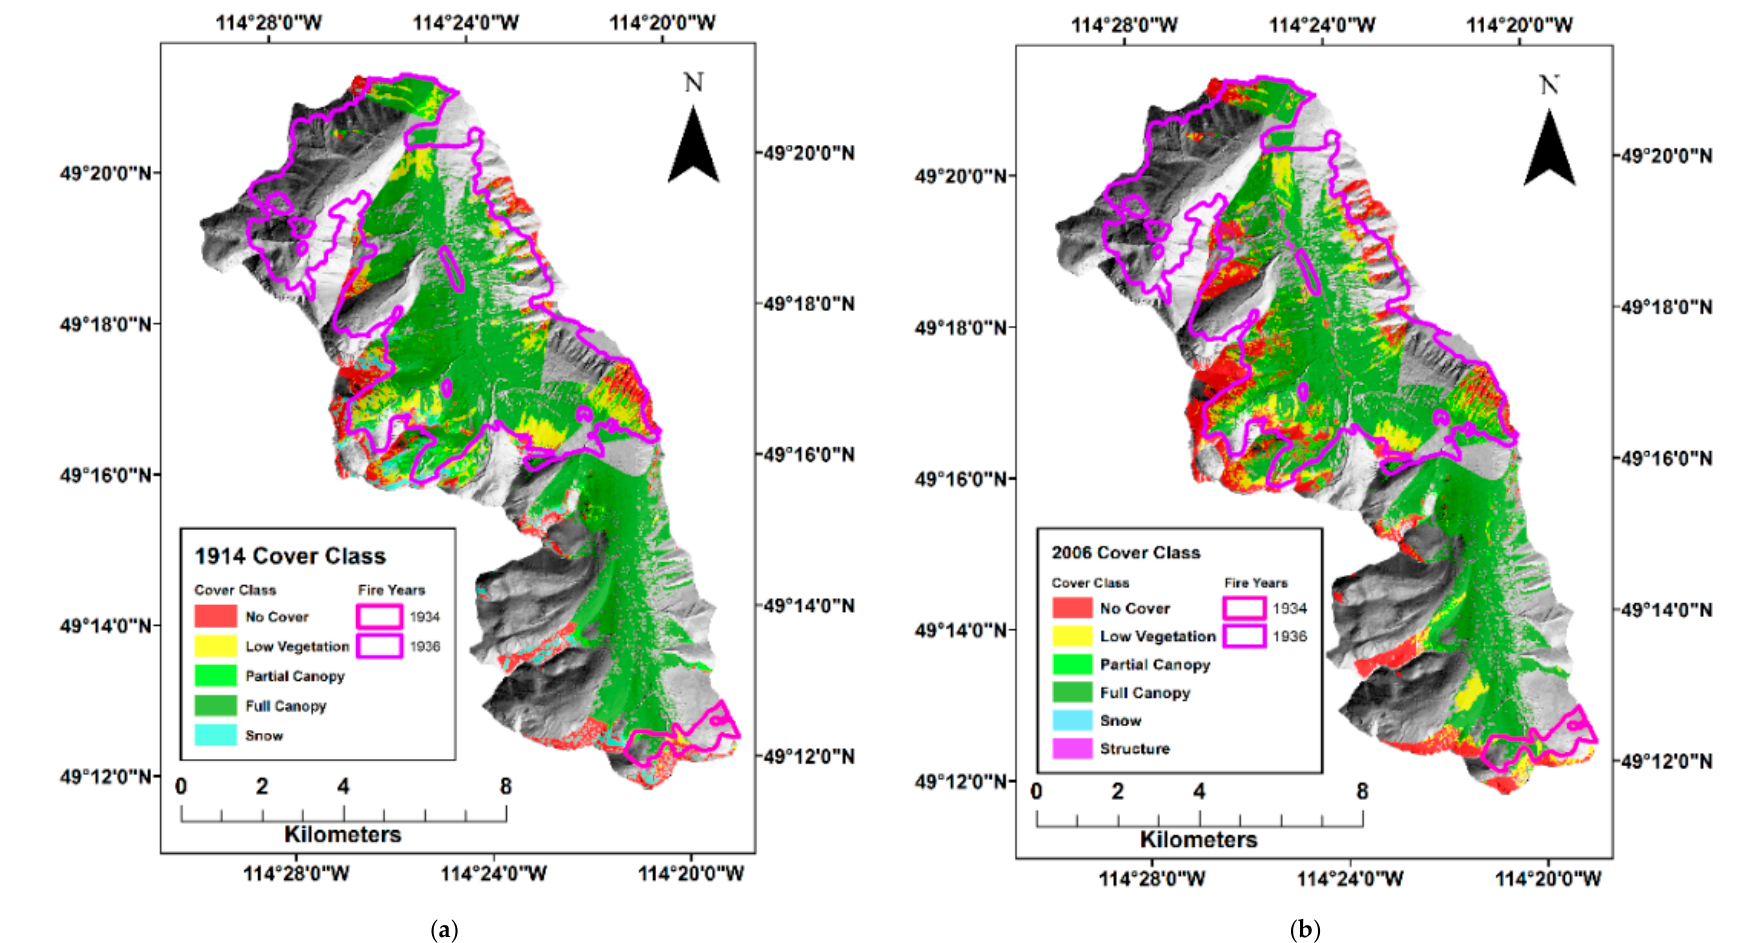
Figure 4. Canopy cover classification for WCW using oblique photography from ( a ) 1914 and ( b ) 2006. Each cell is a 20 × 20 m area, viewed orthogonally, where canopy cover has been assessed, ranging from No Cover to Full Canopy , and including cells with snow cover or modern structures. The extents of the 1934 and 1936 fires are provided for reference [50] .